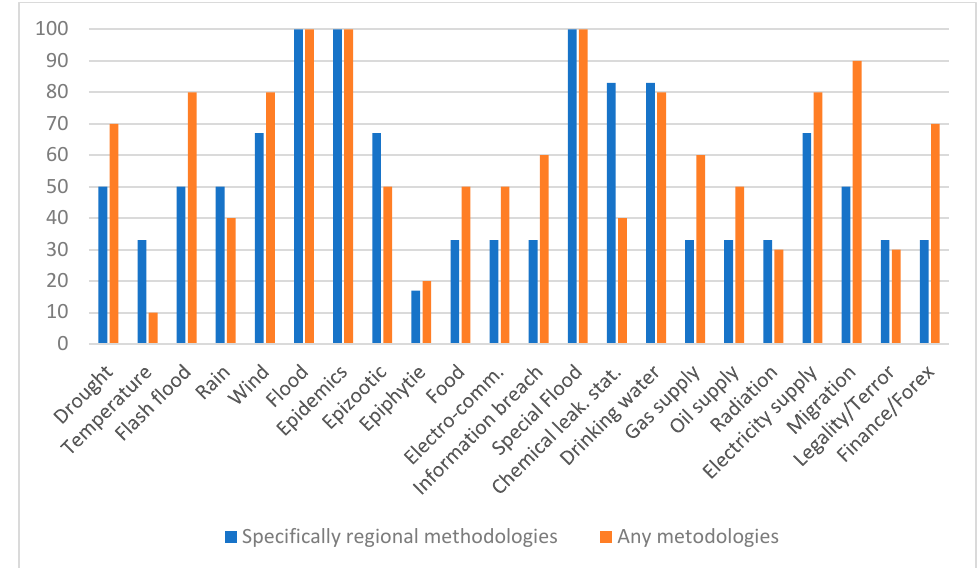
Figure 10. Comparison of existing methodologies.